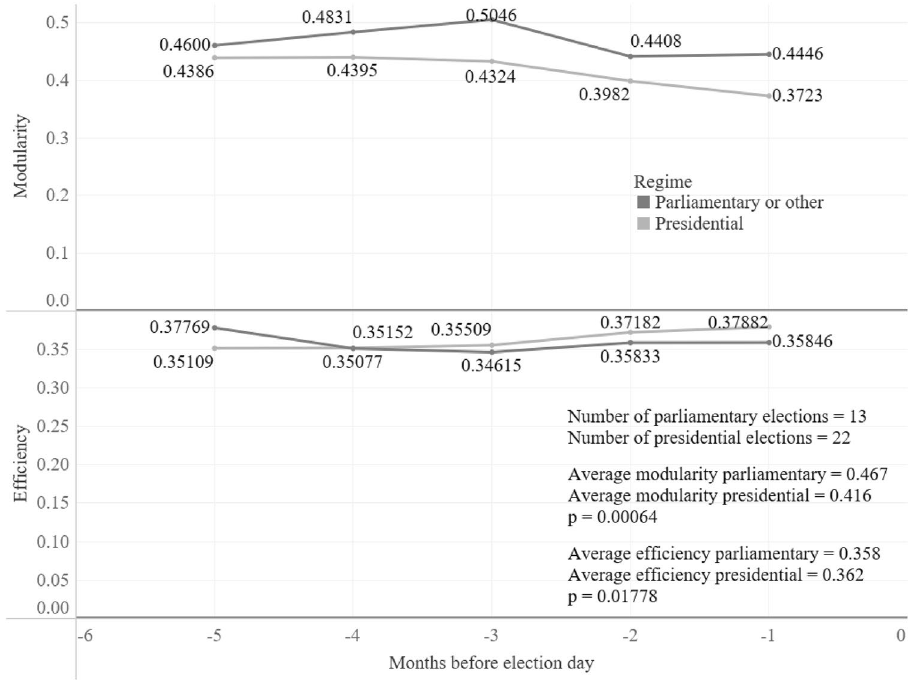
Figure 6. Evolution of modularity and efficiency according to the political regime. A Mann–Whitney U Test was performed to determine if the differences between the means were statistically